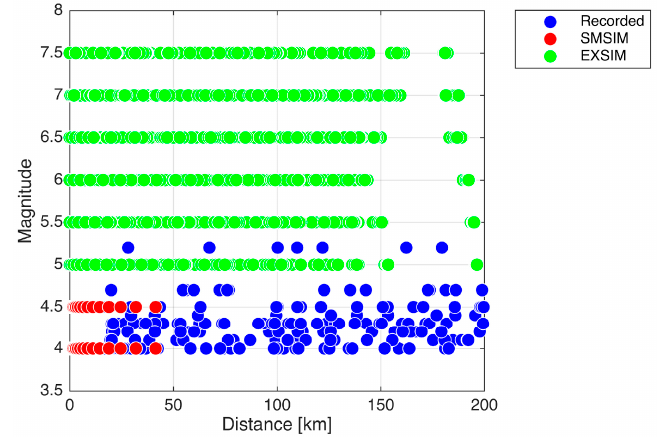
Figure 17. Magnitude–distance distribution of the calibration dataset of the hybrid GMPEs. Blue circles are recorded data; red circles are SMSIM simulations; green circles are the EXSIM simulations.